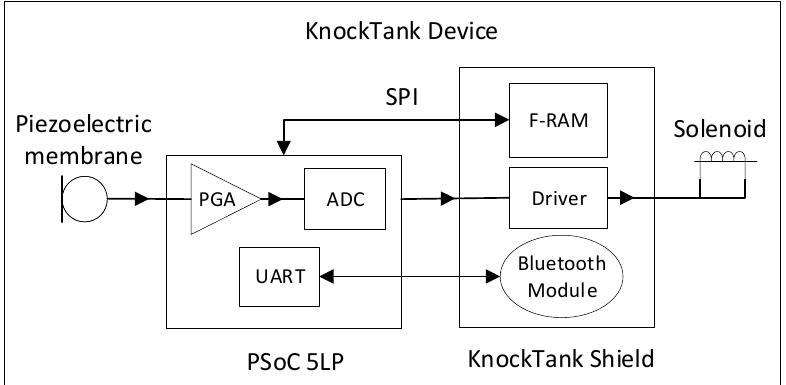
Figure 4. Conceptual schematic of the prototype device.